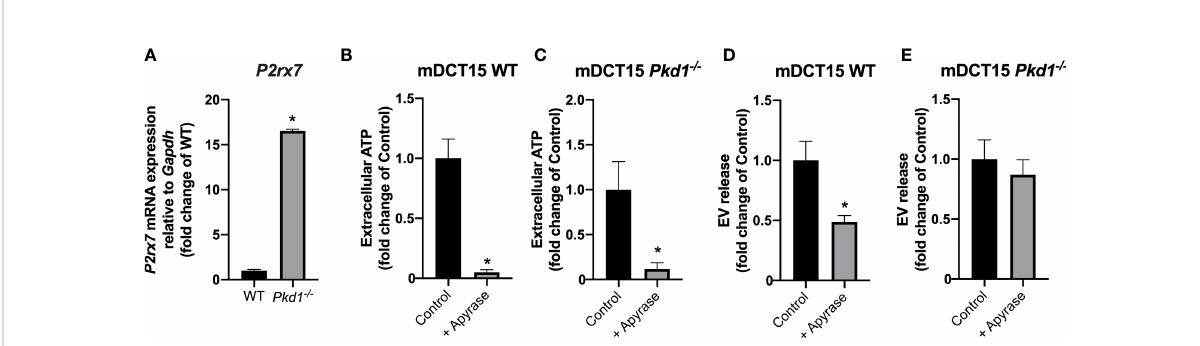
FIGURE 3 Role of the extracellular ATP and purinergic signaling in EV release in wild type and Pkd1 -/- mDCT15 cells. Expression of P2rx7 at the mRNA level was analyzed in wild type and Pkd1 -/- mDCT15 cells and normalized to the expression of Gapdh , used as housekeeping gene (A) . Data (mean ± SEM) are expressed as fold change of the gene expression in wild type (WT) cells. * indicates statistical difference from WT (p < 0.05, n = 3). Extracellular ATP levels were analyzed in WT (B) and Pkd1 -/- mDCT15 cells (C) exposed to vehicle (control) or apyrase (6 U/ml, 24 hours). Data (mean ± SEM) are expressed as fold change of extracellular ATP levels in control cells. EV release was quanti fi ed in suspensions obtained from wild type (D) and Pkd1 - / - mDCT15 cells (E) treated with vehicle (control) or with 6 U/ml apyrase by NTA. Data are shown as mean ± SEM. * indicates statistical difference from control (p < 0.05, n =